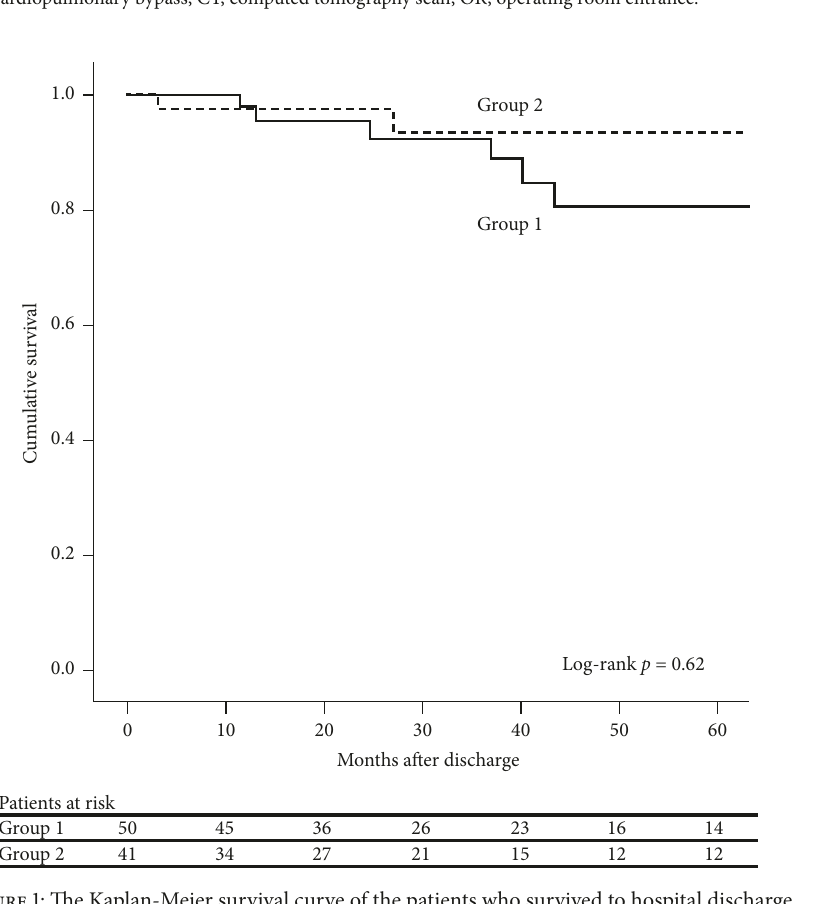
Figure 1: The Kaplan-Meier survival curve of the patients who survived to hospital discharge.